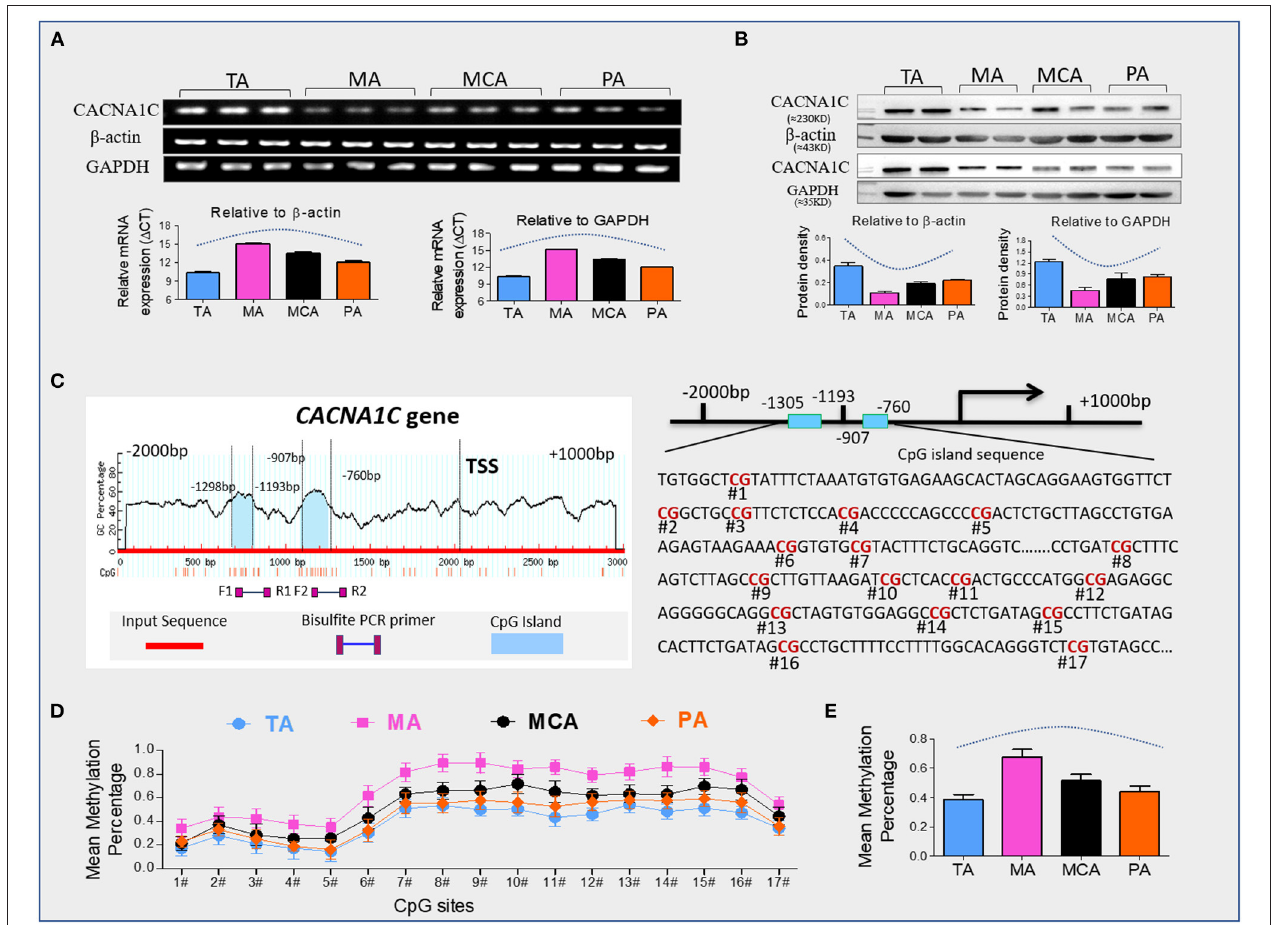
FIGURE 1 | CACNA1C expression and promoter methylation. (A) Quantitative real-time RT-PCR analyses of transcript abundance of CACNA1C expression in primary SMCs (Results of 3 independent experiments), (B) western blot detection of CACNA1C protein levels in primary SMCs (Results of 3 independent experiments), (C) bioinformatic analysis of CpG islands of CACNA1C from upstream − 2kb to downstream + 2kb region. Sequence analysis identified two CpG islands that contain 17 CpG sites, located at positions − 1305 to − 1193, − 907 to − 760 from the translation start site (TSS, defined as position 1) in Cav1.2 gene promoter, (D,E) the mean methylation status of each tested CpG site and total CpG sites in Cav1.2 gene promoter (Results of 10 independent experiments). TA, thoracic aorta; MA, mesenteric artery; MCA, middle cerebral artery; PA, pulmonary artery. Data were expressed as mean ± standard error of mean (SEM), and analyzed using GraphPad Prism version